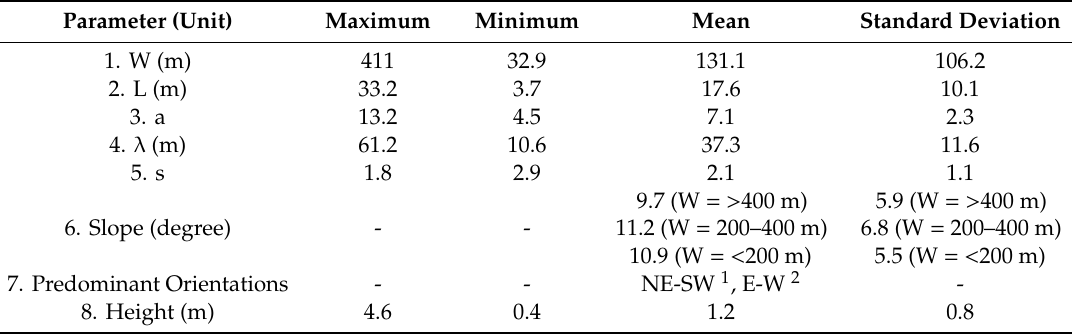
Table 1. Morphometric parameters for the selected 150 TAR